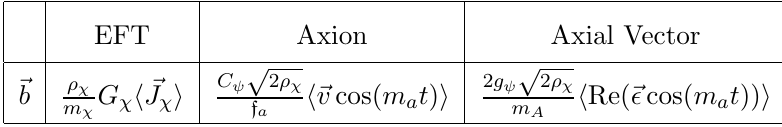
Table 5 . DM currents and preferred